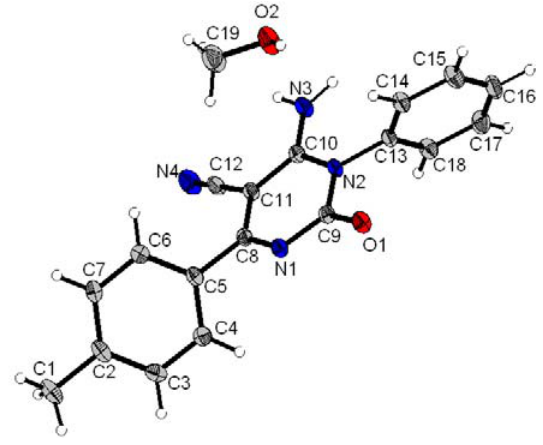
Figure 3. X-ray crystal analysis of compound 3g